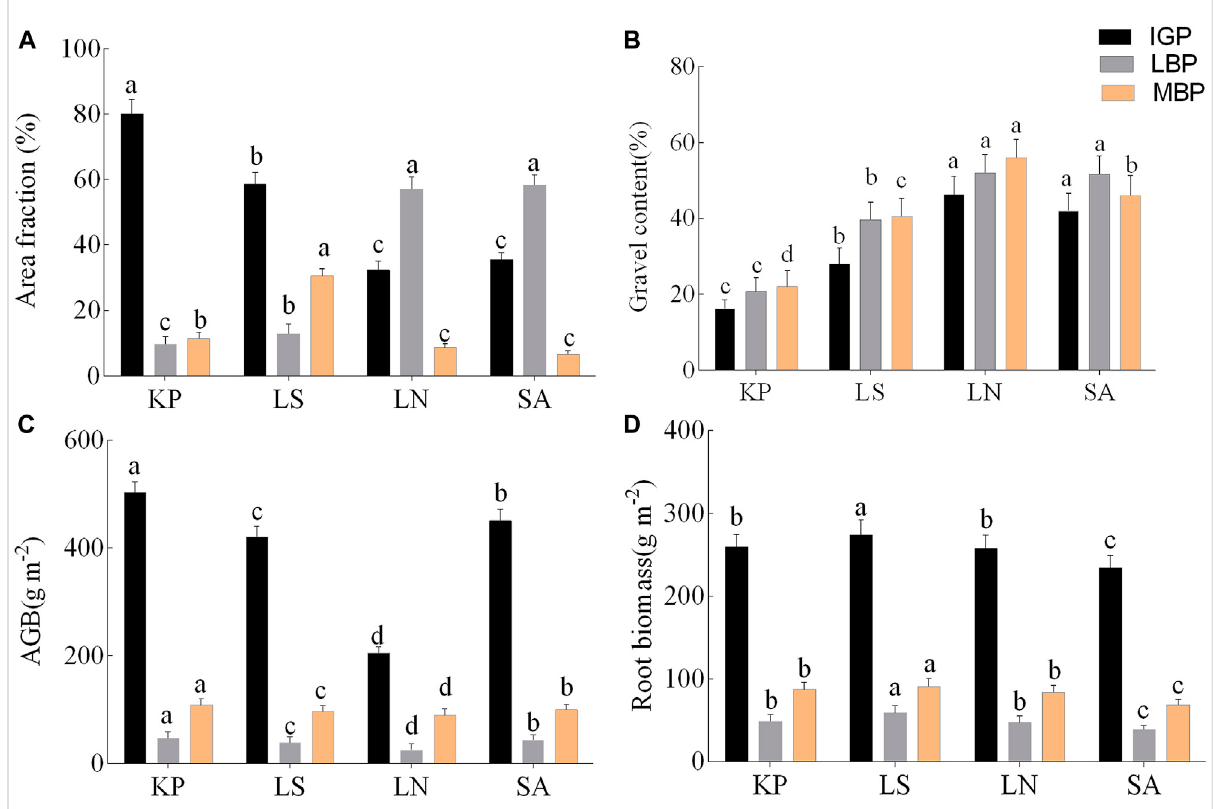
FIGURE 3 Cover fraction (A) , soil gravel (B) , plant biomass (C) , and root biomass (D) in each of the various patches of the four alpine grass species types. Bars with different letters show signi fi cance at p < 0.001. IGP; intact vegetation patch, LBP; large stripped vegetation patch, MBP; medium stripped vegetation patch, KP; Koeleria pers patch, LS; Leymus secalinus patch, LN; Leontopodium nanum patch, SA; Stipa aliena